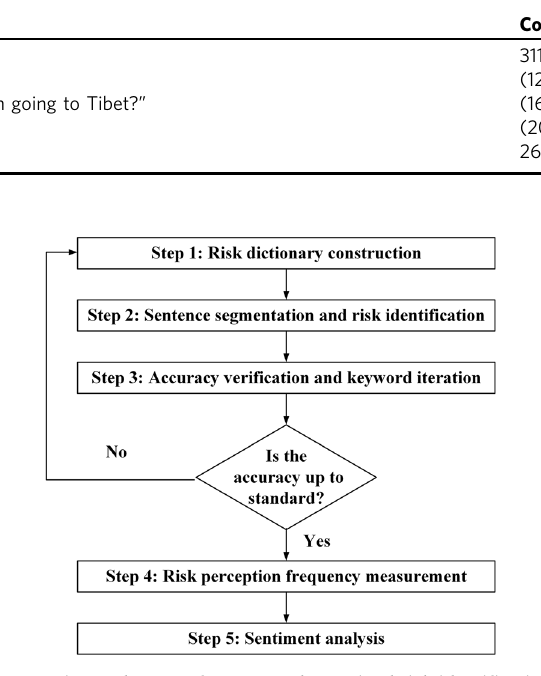
Fig. 4 Experimental steps of post-travel perceived risk identi fi cation. Identi fi cation and measurement process of postravel risk